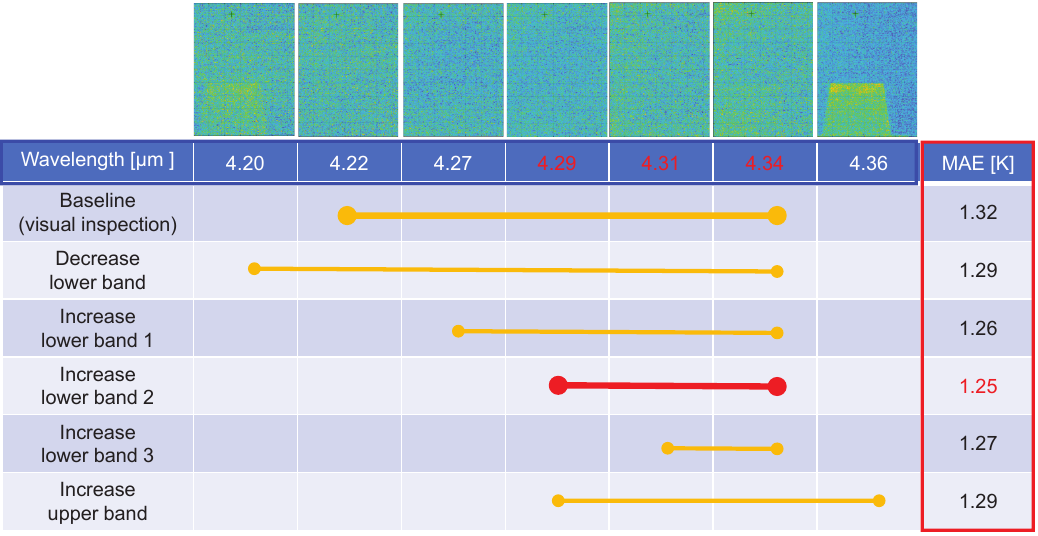
Figure 17. CO 2 band range selection results: Baseline band is selected by visual inspection and the optimal band range is selected by maximizing mean absolute error (MAE)